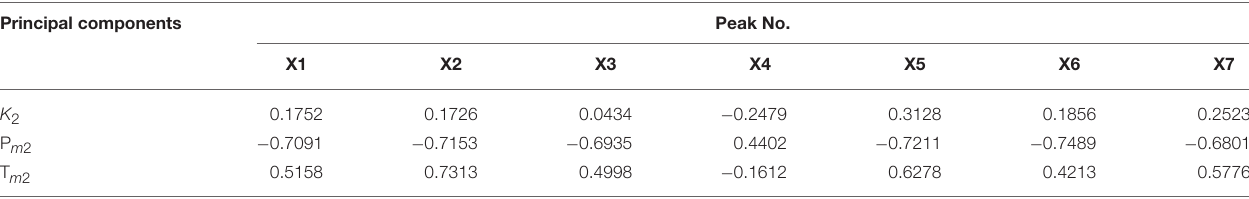
TABLE 2 | The correlation coefficients between the previously identified common characteristic peaks and previously calculated principal thermokinetic parameters. Principal components Peak No.